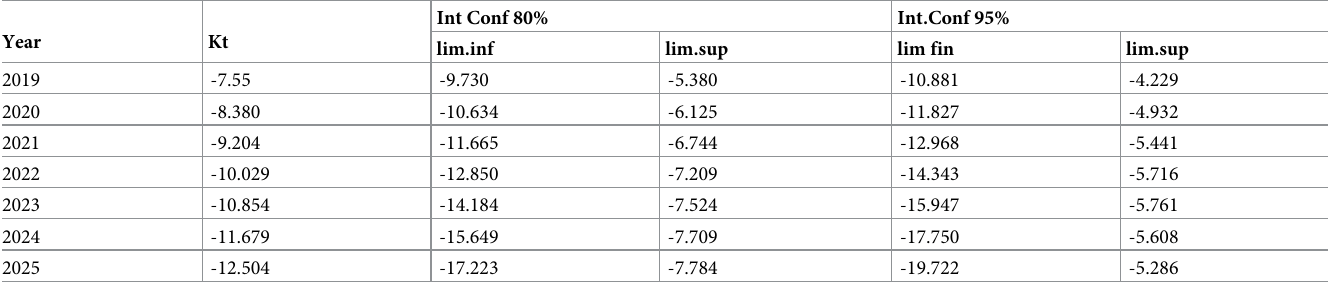
Table 8. k t estimated for males (2019–2025) by the ARIMA model (0, 2, 2).